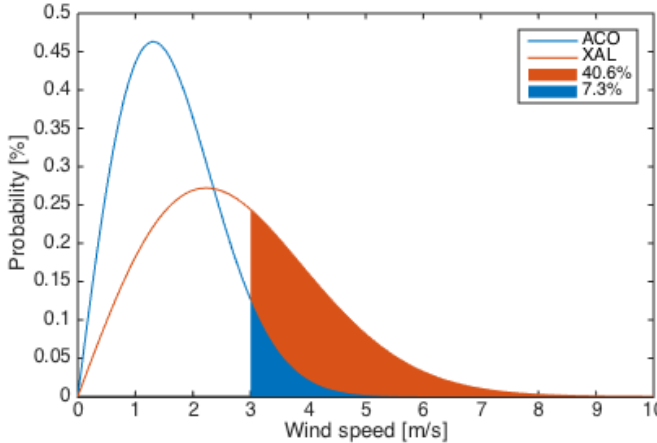
Figure 16. Rayleigh distributions of ACO and XAL , which are the locations with minimum and maximum expected wind speeds of the analyzed